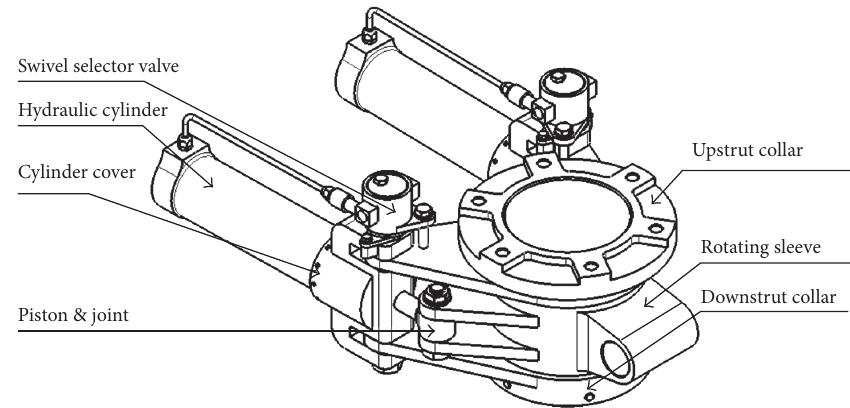
Figure 5: Design model of dual actuator nose wheel steering mechanism.